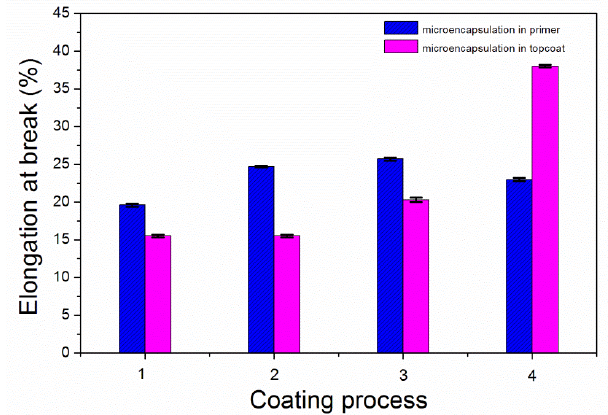
Figure 12. Effect of different coating processes on elongation at break of the coating (samples 1–4 from Table 1).